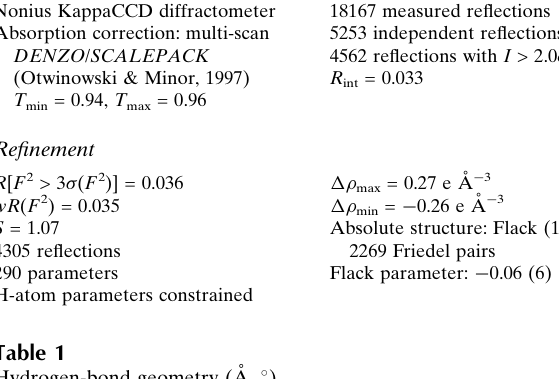
Hydrogen-bond geometry (A˚ , (cid:4)